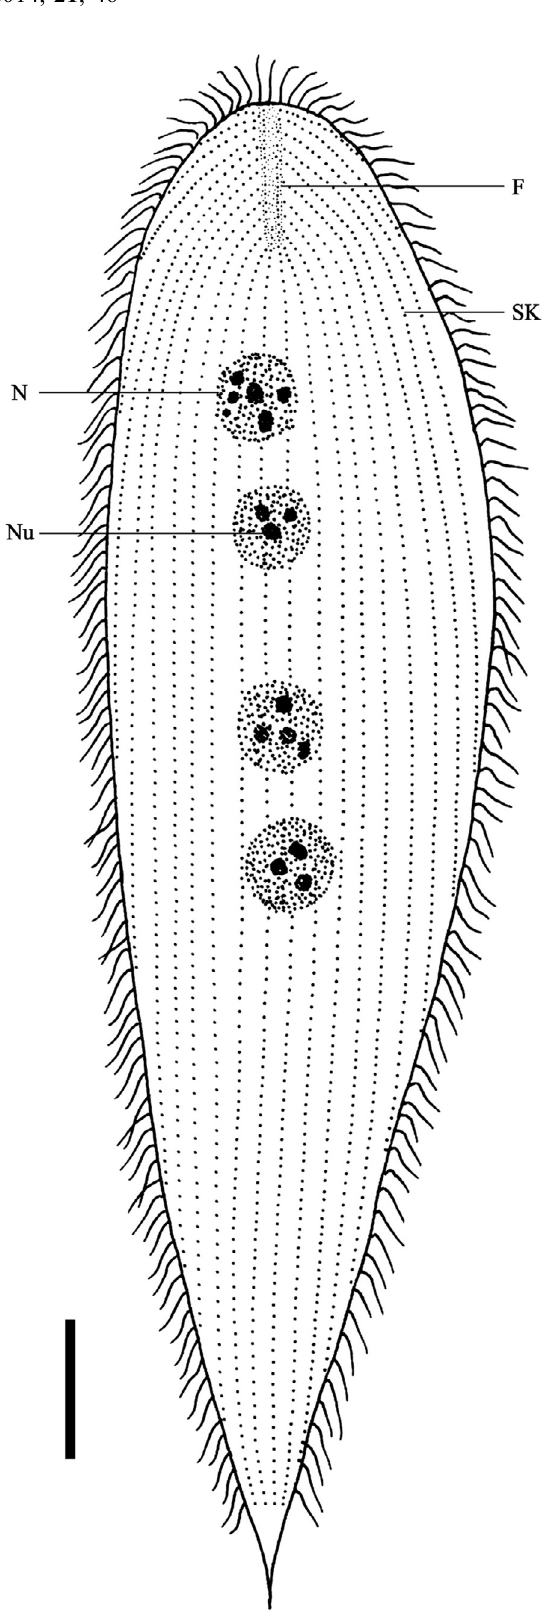
Figure 3. Schematic drawing of Protoopalina pingi Nie, 1935, showing the general form and structures: falx (F), nucleus (N), nucleolus (Nu) and somatic kineties (SK). Scale bar = 10 l